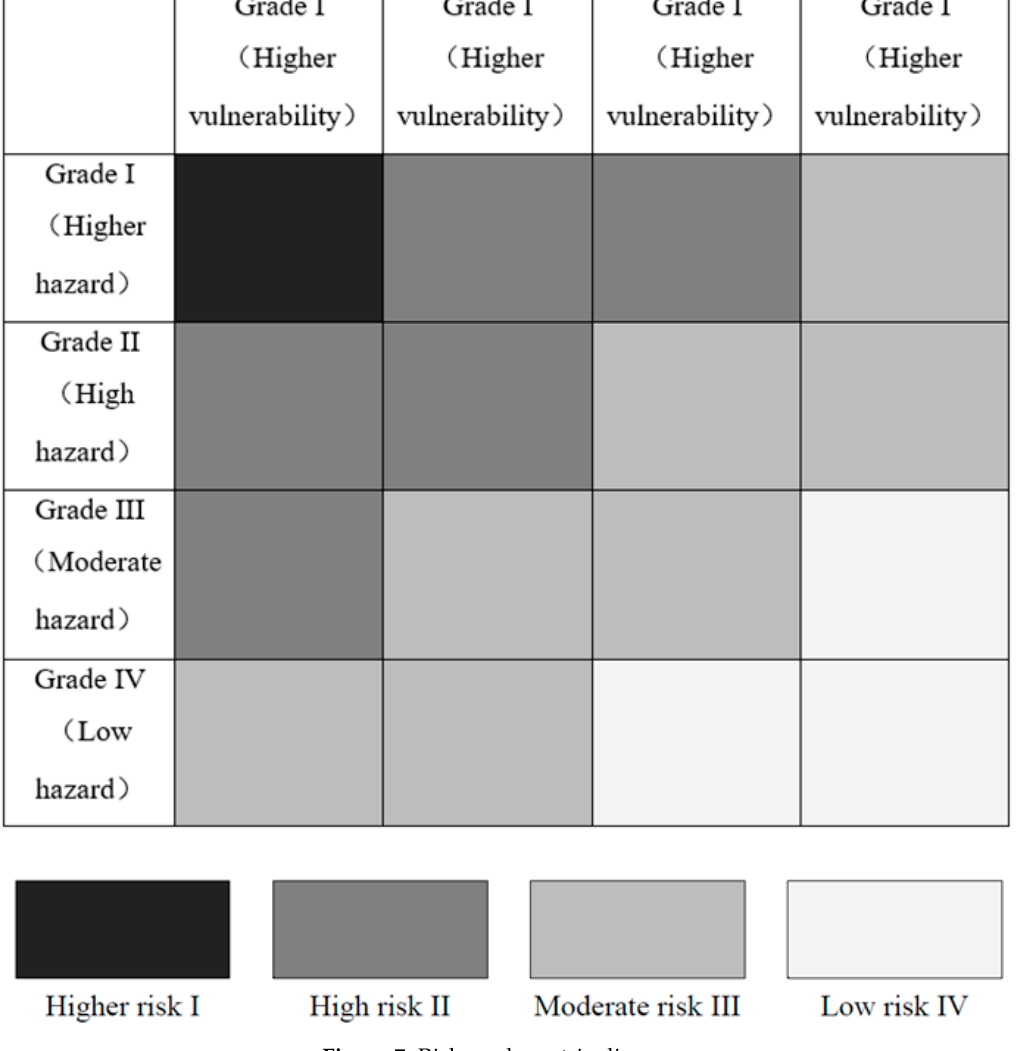
Figure 7. Risk grade matrix diagram.